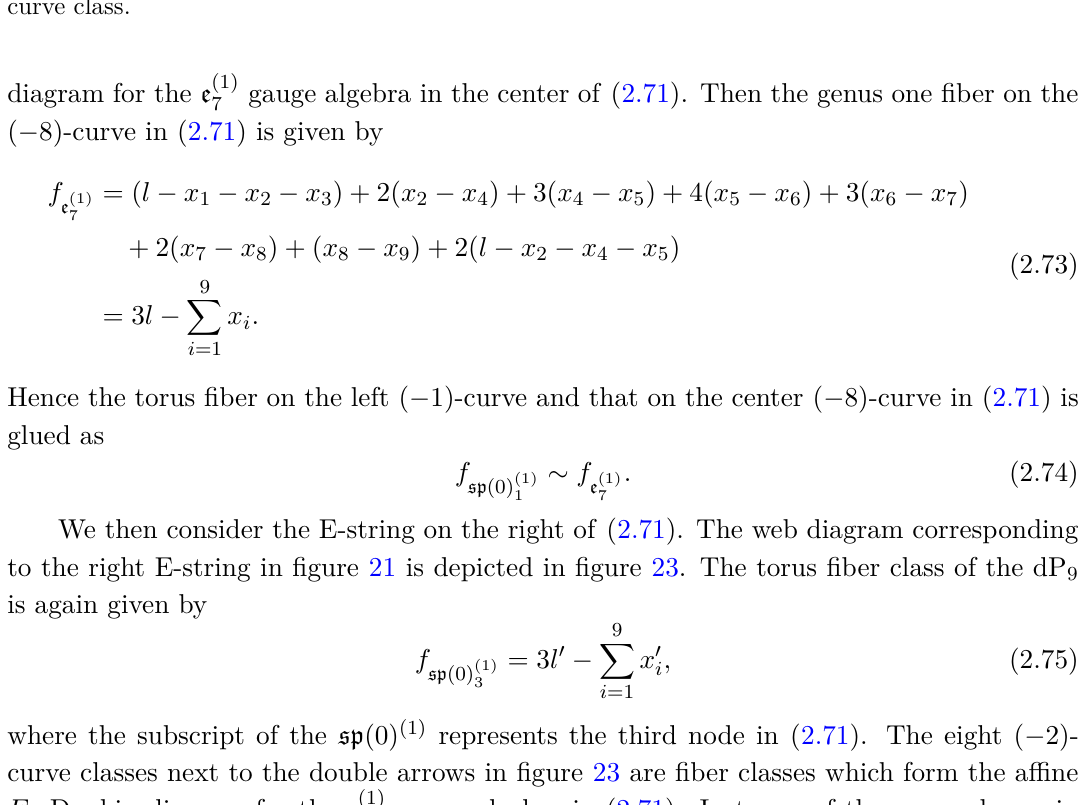
Figure 22. The web diagram of dP 9 which corresponds to the E-string on the left in (2.71). l is the hyperplane class of P 2 and x i ( i = 1 , · · · , 9) are the exceptional curve classes. A curve class next to a double arrow implies that the length of the double arrow is related to the volume of the curve